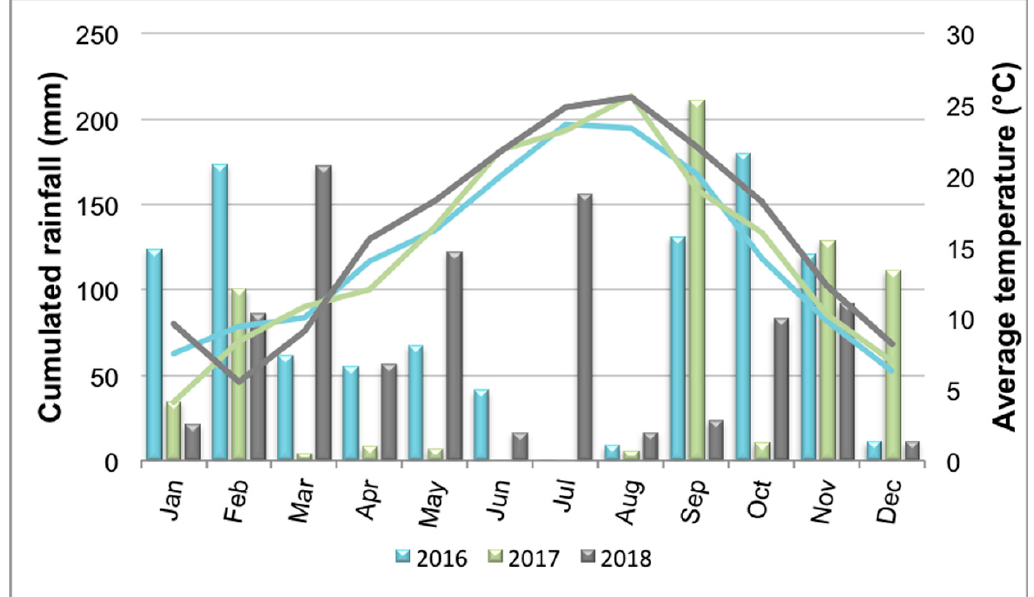
Figure 1. Monthly cumulated rainfall and monthly average temperatures (January 2016–December 2018) recorded by the meteorological station in Siberia, Crespina-Lorenzana (Pisa, Italy) (43°35 ′ 31.2” N 10°32 ′ 38.4” E)